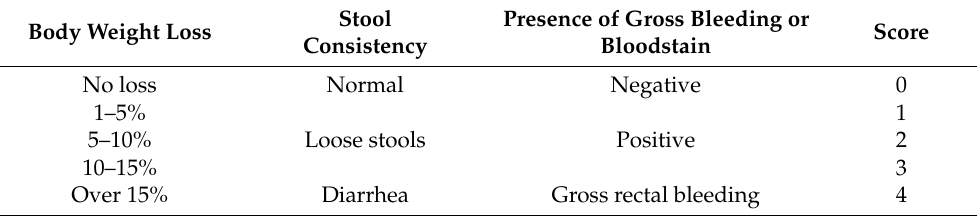
Table 1. The DAI scoring